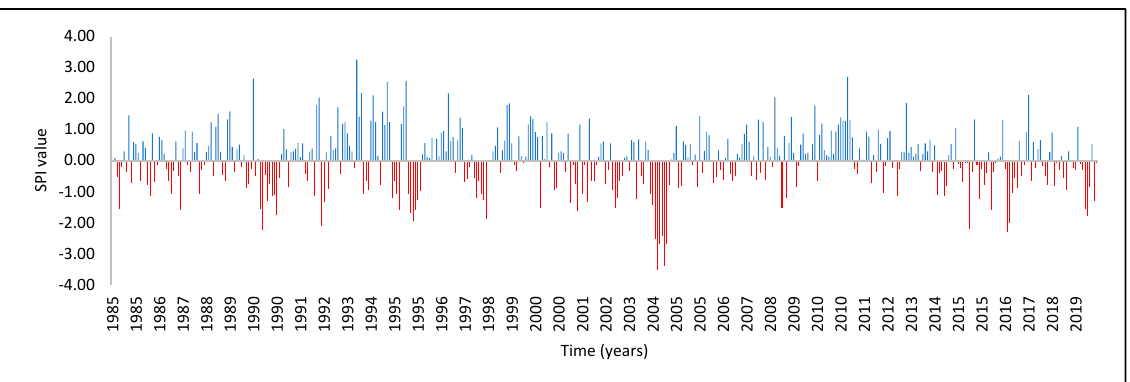
Figure 9. SPI time series, Chalan station in the period (1985–2019).